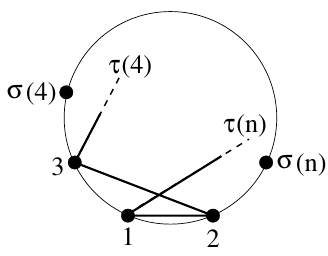
Figure 2 . CHY prescription for computing the double-partial amplitude m (23 (cid:28) 1 j 13 (cid:27)